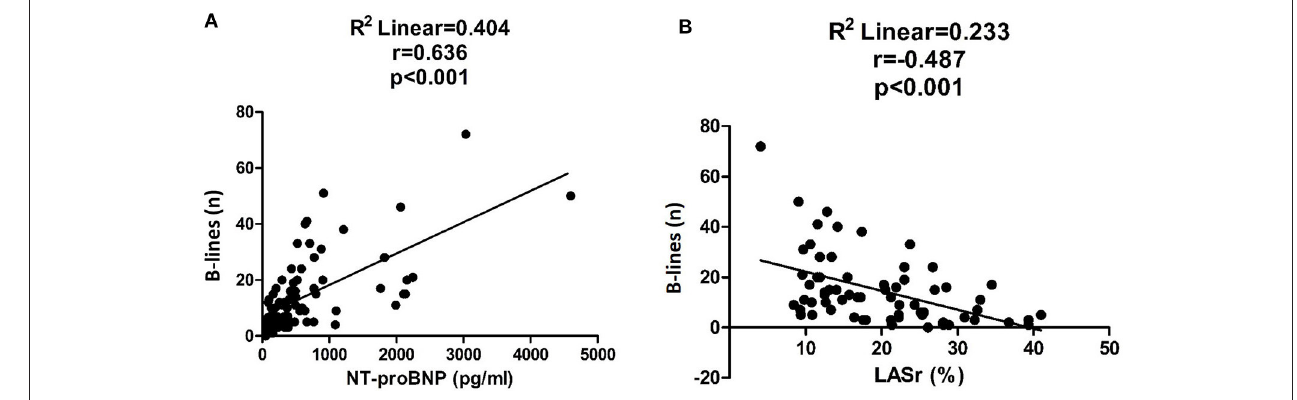
FIGURE 2 | Correlation between the number of B-lines and NT-proBNP levels (A) and LASr values (B) .